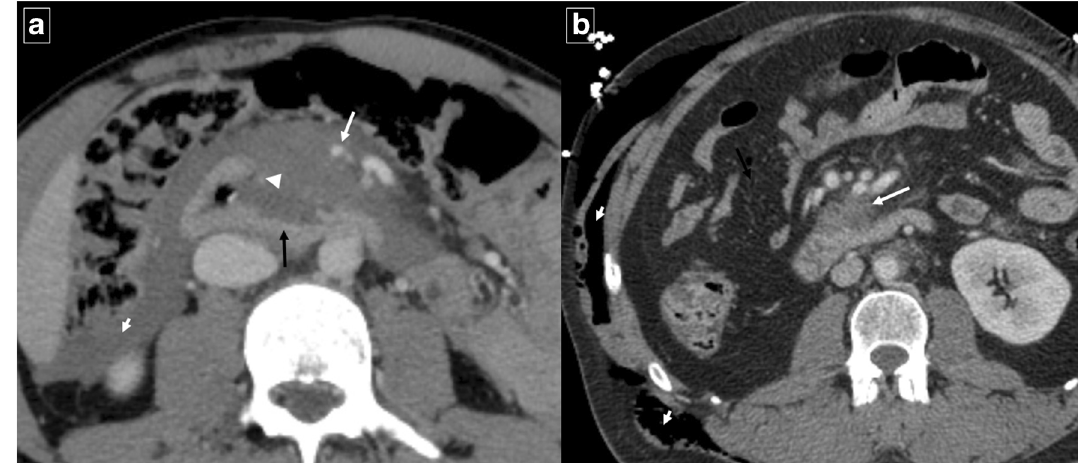
Fig. 21 Duodenal trauma in different patients. a A 20-year-old man with blunt abdominal trauma. Contrast-enhanced CT shows an extensive pancreaticoduodenal hematoma with displacement of the mesenteric vessels to the left (white arrow) and disruption of the wall of the third duodenal portion (black arrow) with active extravasation of intravenous contrast (arrowhead). Note the abundant retroperitoneal fluid (short